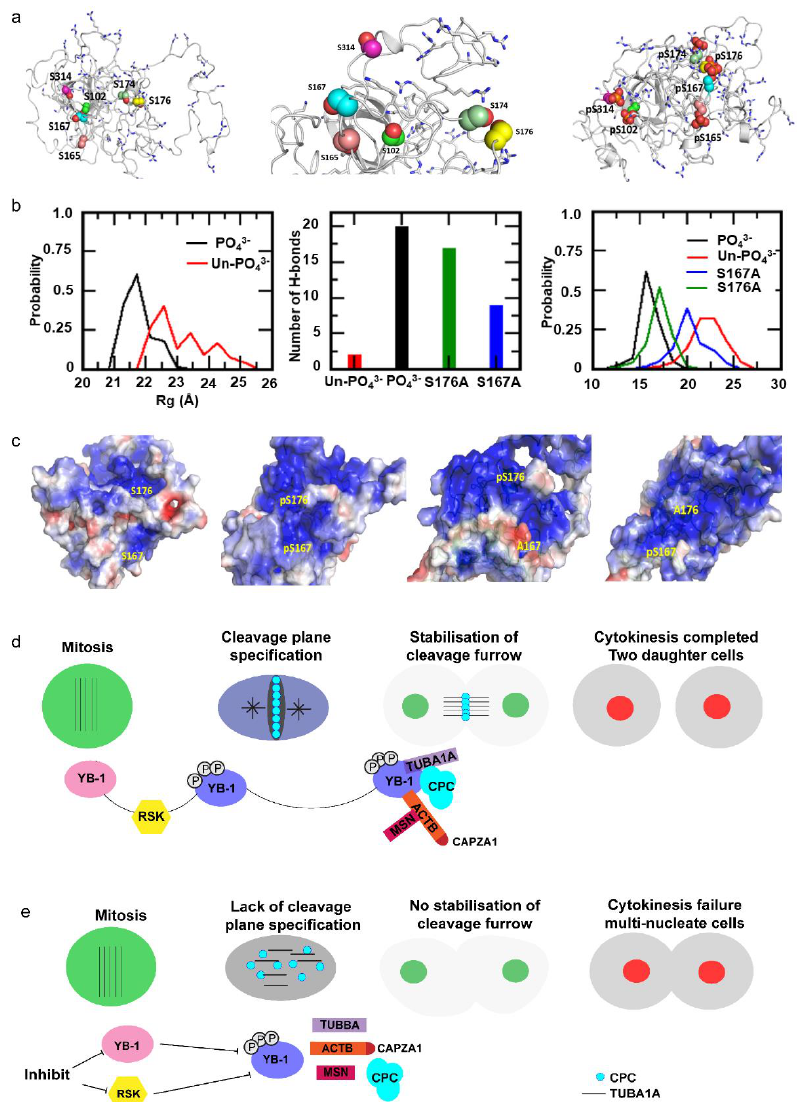
Figure 7. Phosphorylation defective YB-1 mutants do not rescue from cytokinesis failure. ( a , b ) Shows the starting phase of the cell cycle for each tracked A549/F cell using time lapse imaging and quantitates the amount of time spent in each phase of the cell cycle and the number of divisions that each cell undergoes. ( c ) Quantitation of G 1 phase transit time. ( d ) Quantitation of S-G 2 -M phase transit time. ( c , d ) Significance was determined using the Mann – Whitney U test, * p < 0.05, ** p < 0.01, *** p < 0.001 and **** p < 0.0001.